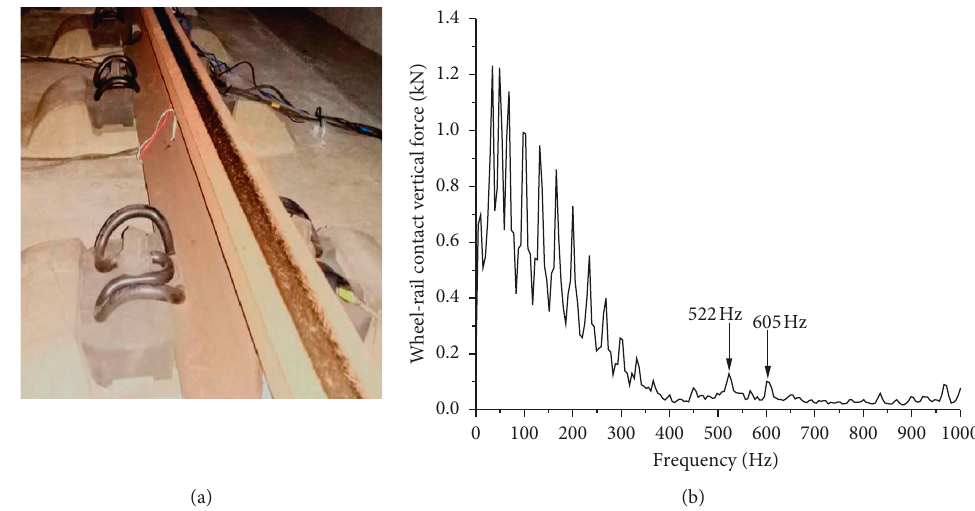
Figure 13: On-site test (a) and output (b) of wheel-rail vertical contact